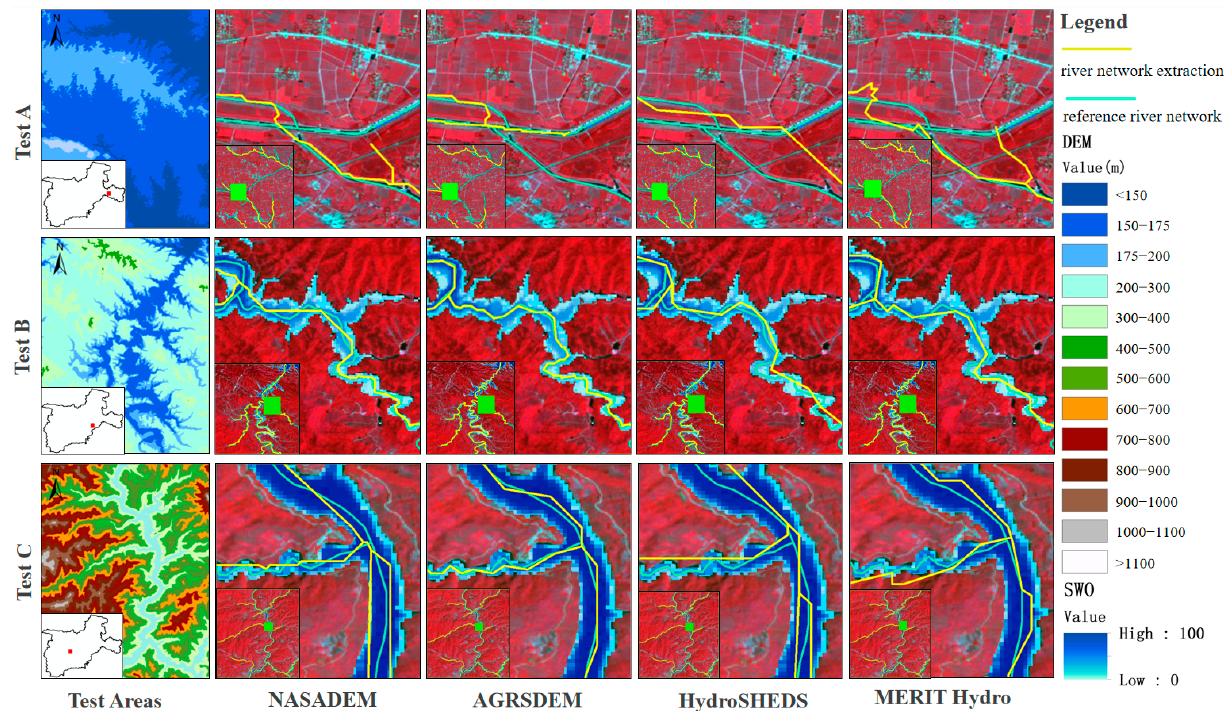
Figure 8. River network based on four data in three test areas.